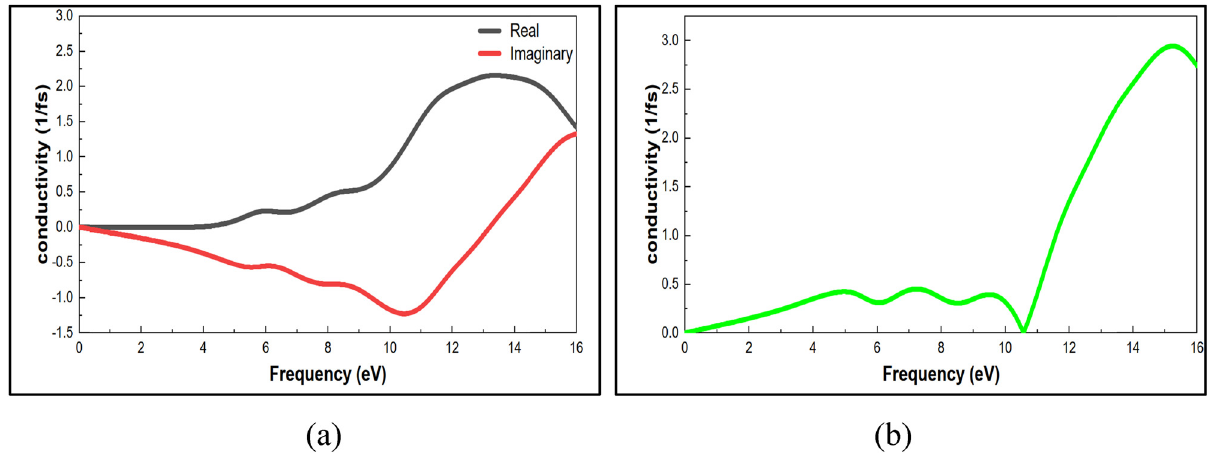
Figure 13: ( a ) Real and imaginary optical conductivity properties of nylon 66. ( b ) Optical conductivity properties of nylon